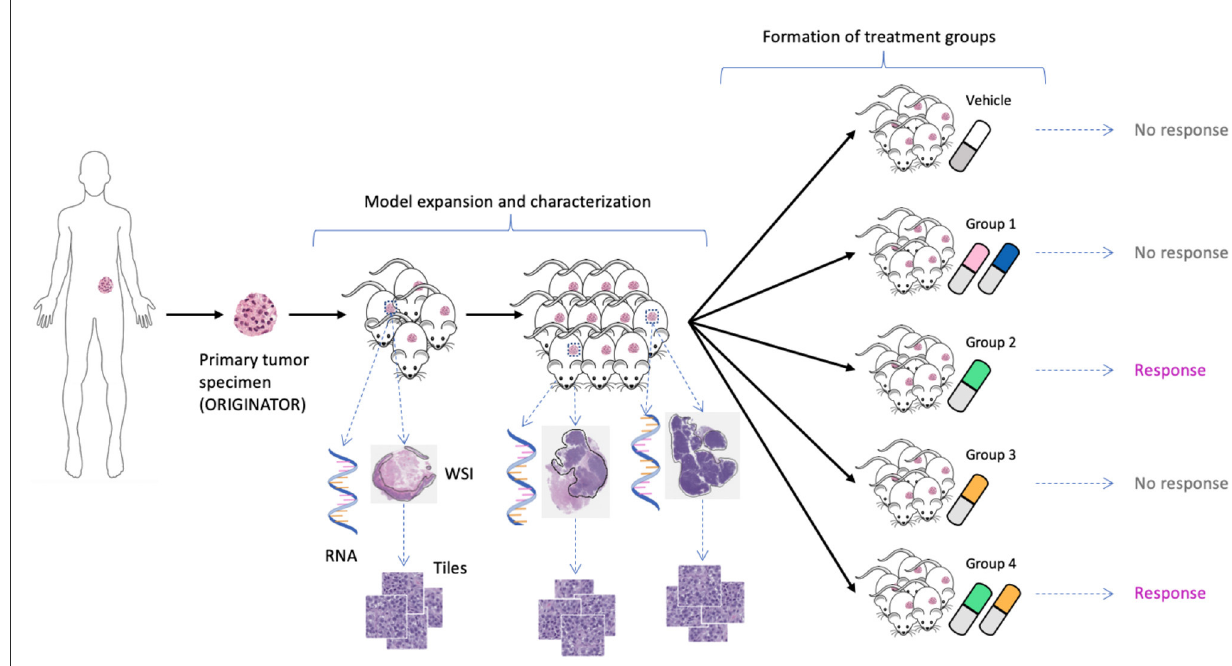
FIGURE1 Expansion of tumor tissue from the source specimen (ORIGINATOR) to mice across multiple passages. Mice originated from the same specimen are divided into a control group and multiple treatment groups. Tumors from certain mice were histologically and molecularly profiled, resulting in whole-slide images and omics profiles.